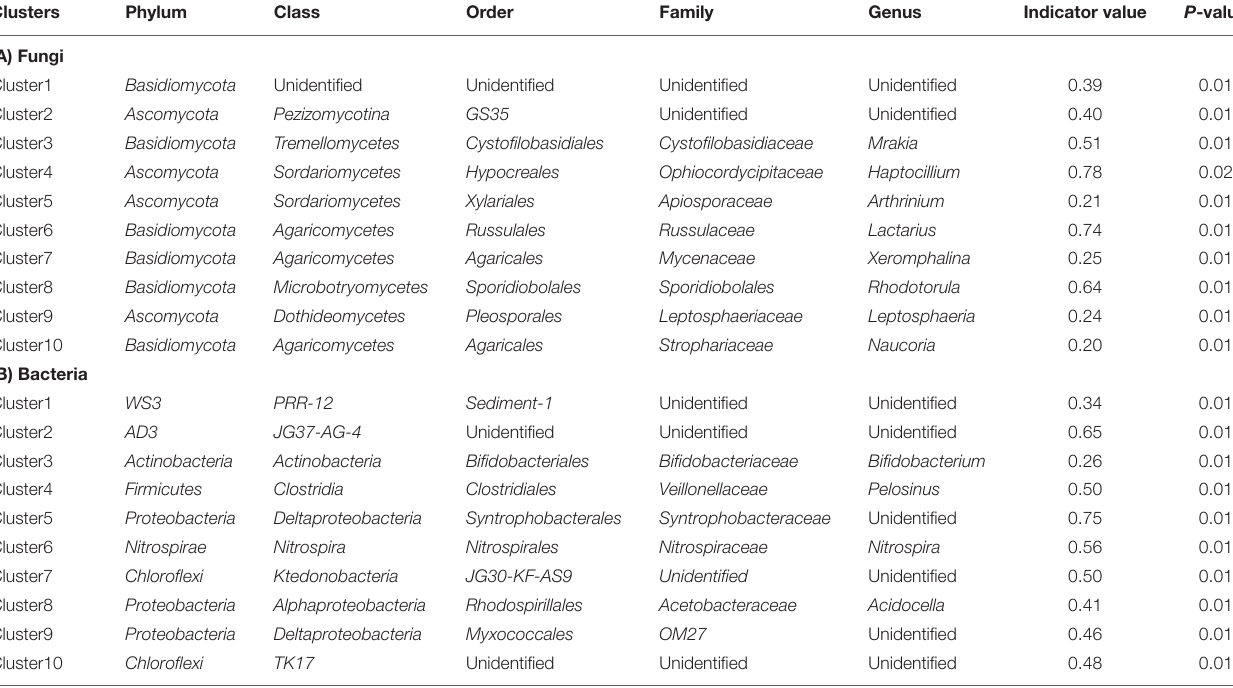
TABLE 3 | List of the most reliable indicator taxa for fungal (A) and bacterial (B) clusters. Clusters Family Genus Indicator